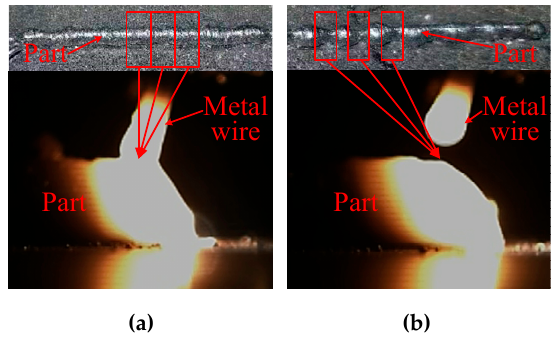
Figure 2. The morphology of resistance heating metal wire additive manufacturing. ( a ) Continuous melting and ( b ) disconnected melt.